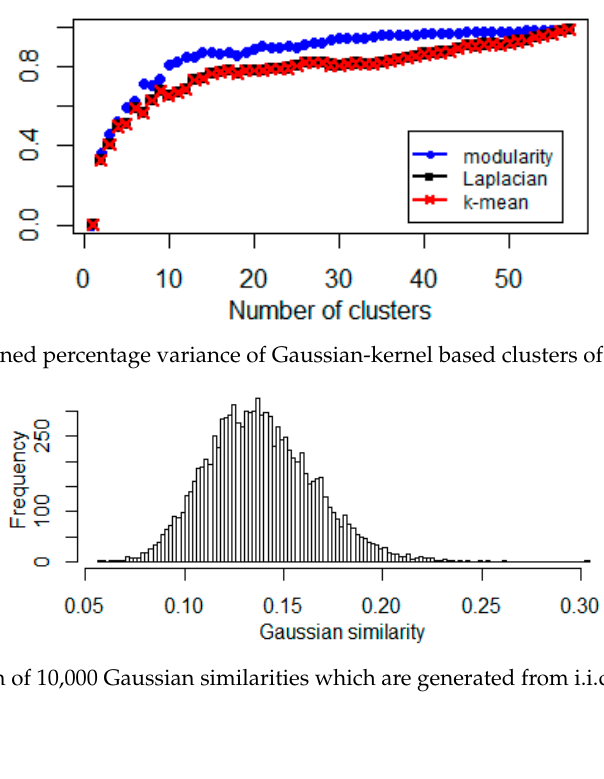
Figure 4. Largest eigenvalues of Gaussian- and relative entropy-based normalized modularity matrices.